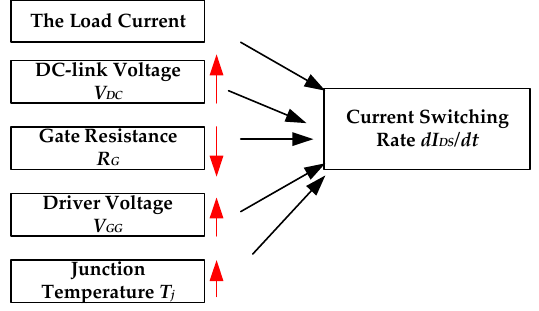
Figure 6. Effect of increasing influence factors on dI DS /dt.